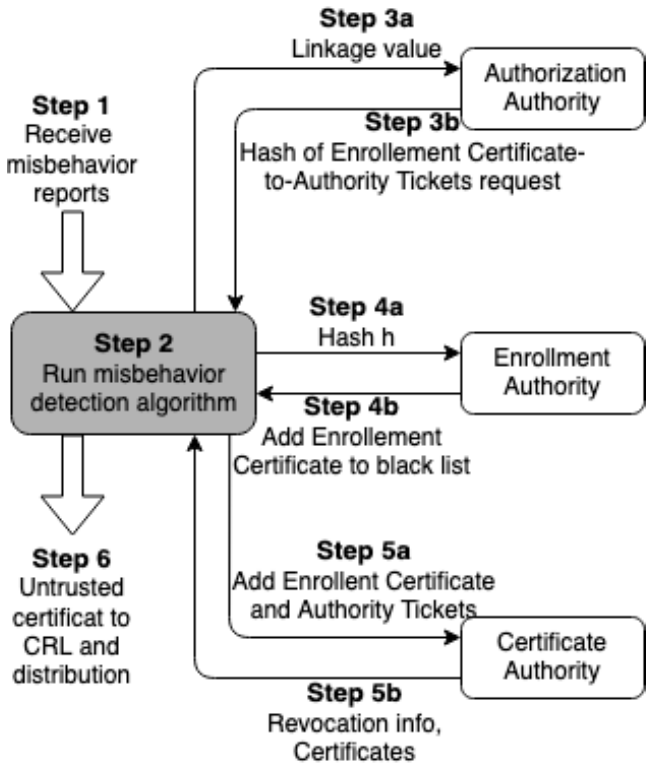
Figure 1. Reports of OBUs to misbehavior authority of malicious vehicles and the authorities’ conducted process to the linkage of authorization tickets and their corresponding ECs and attributes to report them into the